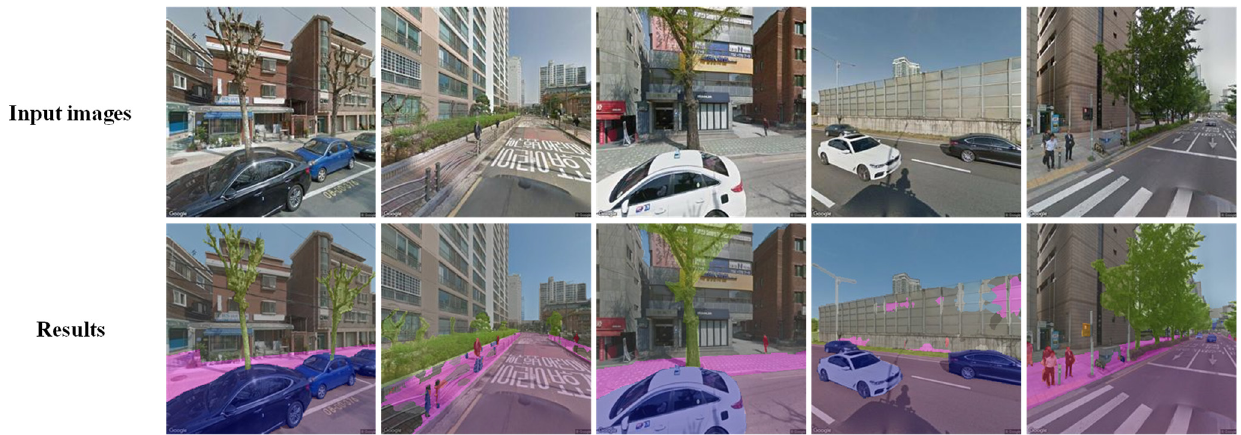
Figure 5. Segmentation results for GSV images.